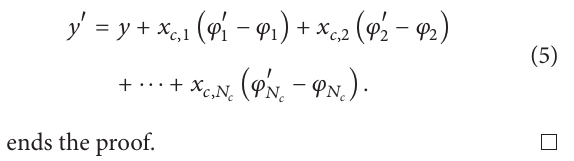
Algorithm 2. The coherent column replacement method